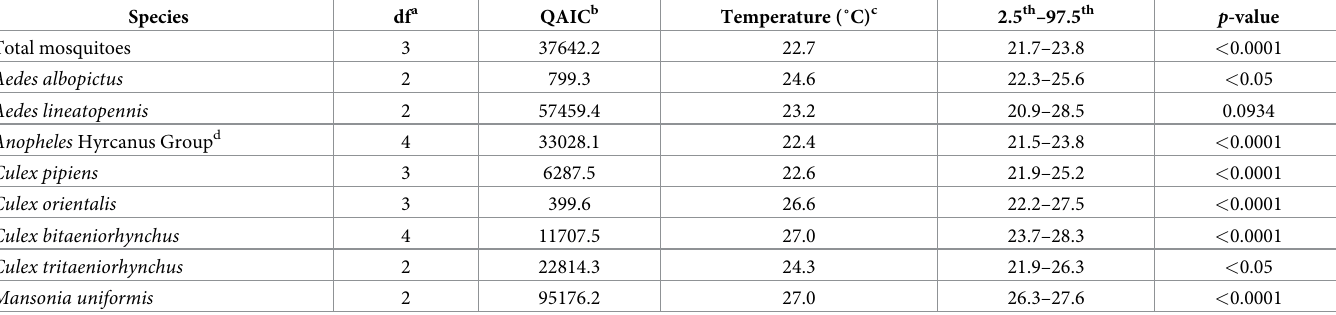
Fig 5. Relationship of Generalized Additive Model (GAM) between the abundance of selected mosquito species and daily mean temperatures, adjusted for the cumulative precipitation based on a 2-week lag effect for mosquitoes collected during the 2018 and 2019 mosquito season using Mosquito Magnet 1 traps operated at 12 collection sites at USAG Humphreys. The solid line is the estimated log (relative risk) as density of mosquitoes by species and dashed line is the 95% confidence interval. � Adjusted for a lag 2-week lag for cumulative precipitation, year, season, and presence of insecticide fogging. RR, relative risk. https://doi.org/10.1371/journal.pone.0240363.g005 decreases above certain temperatures [13, 22–24]. Therefore, it is important to identify opti- mum temperature ranges at which the maximum mosquito abundance occurs for each species to effectively implement vector control measures. An estimate of the nonlinear relationship between mosquito abundance and daily average temperatures, based on the lag effect that takes into account the period of 2 weeks from egg to adult before the collection date, was per- formed [25, 26]. In subsequent years, these data can be used to determine the effectiveness of vector control measures, e.g., different types of adult fogging measures (e.g., ULV or thermal fogging) or larval control (e.g., use of Bti) to reduce disease risks. Culex orientalis and Cx . pipiens , which were collected in relatively high numbers, were in the same Culex group, but the maximum abundance temperatures differed by 4˚C, 26.6˚C and 22.6˚C, respectively. A previous study conducted in the same region showed that the JEV Genotype V was detected in Cx . bitaeniorhynchus collected near the demilitarized zone (DMZ) [16, 27] and later at other sites, including USAG Humphreys in 2018 [28, J Hang Per- sonal Communication]. A viral genome associated with the Chaoyang virus, a potential anthropod-specific flavivirus, was isolated from Ae . vexans nipponii also accounted for a signif- icant proportion of mosquitoes collected [29]. However, Ae . vexans nipponii is a flood water mosquito and relative abundance increased linearly with no observed threshold temperature, and our model was unable to provide the maximum density temperature range. Thus, popula- tions of Ae . vexans nipponii may be more related to flooding of larval habitats than tempera- tures during the mosquito season. A Rickettsia sp. was recently isolated from Mn . uniformis collected near the DMZ, but has not been detected in the large numbers of Mn . uniformis col- lected and assayed using next generation sequencing (NGS) at USAG Humphreys, and which accounted for the most of the mosquitoes collected during 2019 [30]. Additionally, Getah virus, which is of veterinary importance, was identified in mosquitoes collected near the DMZ, Table 5. Estimated empirical mean temperature for maximum abundance of mosquitoes by species collected using Independence 1 model Mosquito Magnet 1 traps. Species df a QAIC b Temperature (˚C) c 2.5 th –97.5 th p -value Total mosquitoes 3 37642.2 22.7 21.7–23.8 < 0.0001 Aedes albopictus 2 799.3 24.6 22.3–25.6 < 0.05 Aedes lineatopennis 2 57459.4 23.2 20.9–28.5 0.0934 Anopheles Hyrcanus Group d 4 33028.1 22.4 < 0.0001 Culex pipiens 3 6287.5 22.6 21.9–25.2 < 0.0001 Culex orientalis 3 399.6 26.6 22.2–27.5 < 0.0001 Culex bitaeniorhynchus 4 11707.5 27.0 23.7–28.3 < 0.0001 Culex tritaeniorhynchus 2 22814.3 24.3 Mansonia uniformis 2